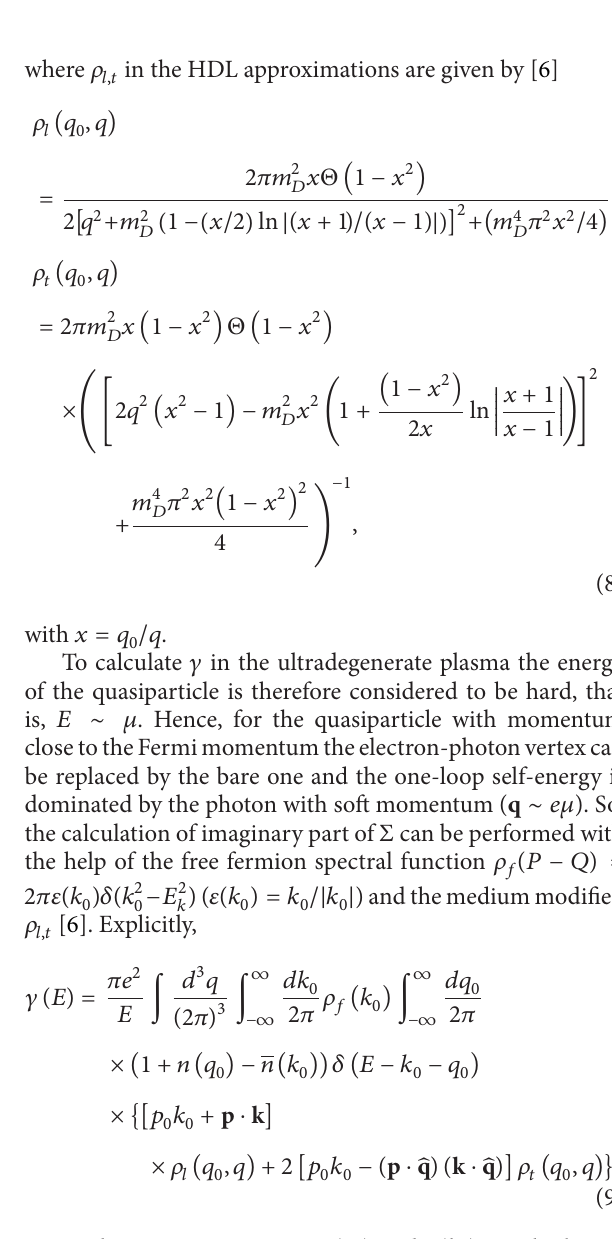
Figure 2: Feynman diagram for 𝑒 − 𝑒 − → 𝑒 − 𝑒 − scattering process with effective photon